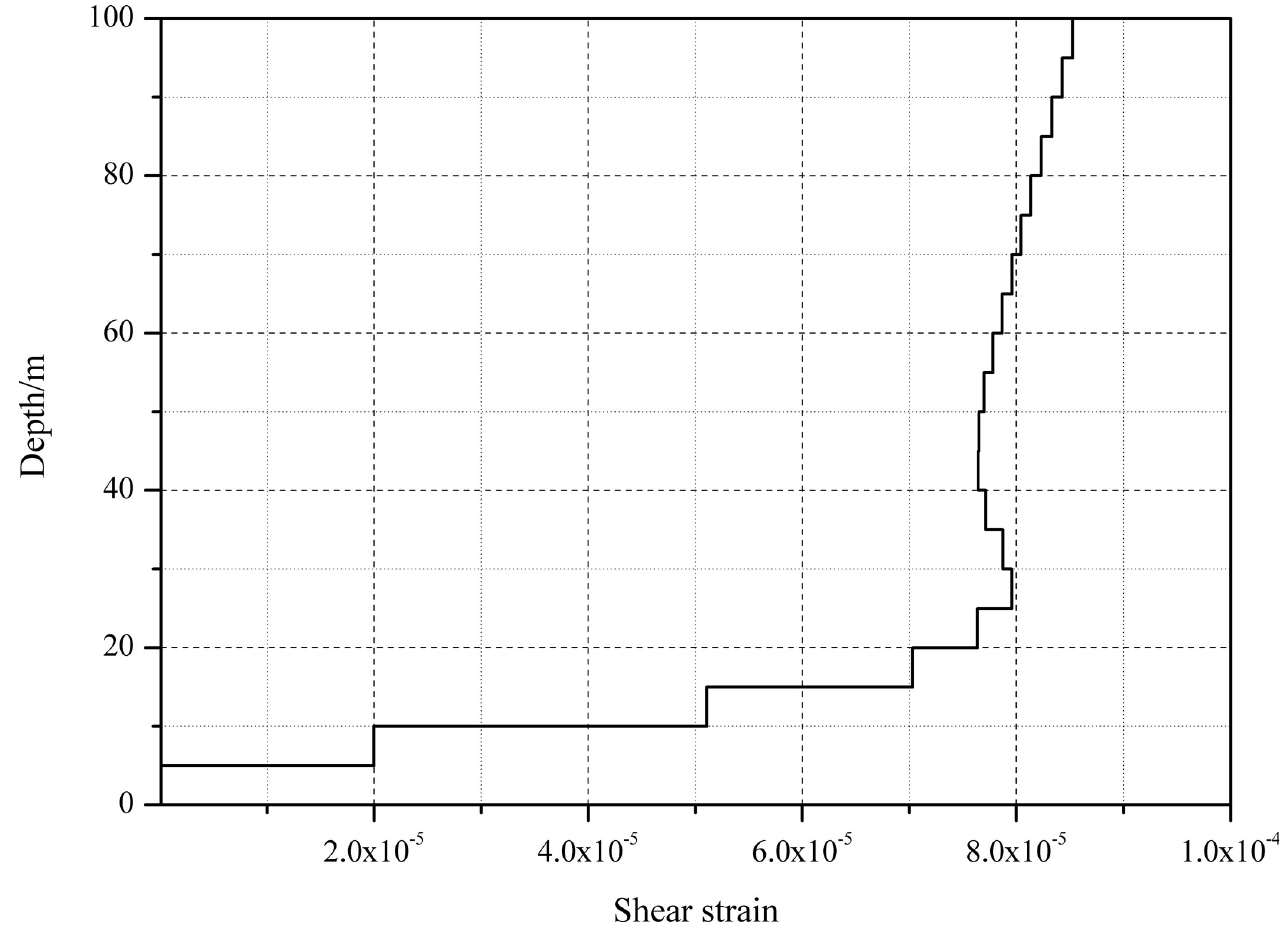
Fig 6. The distribution of the shear